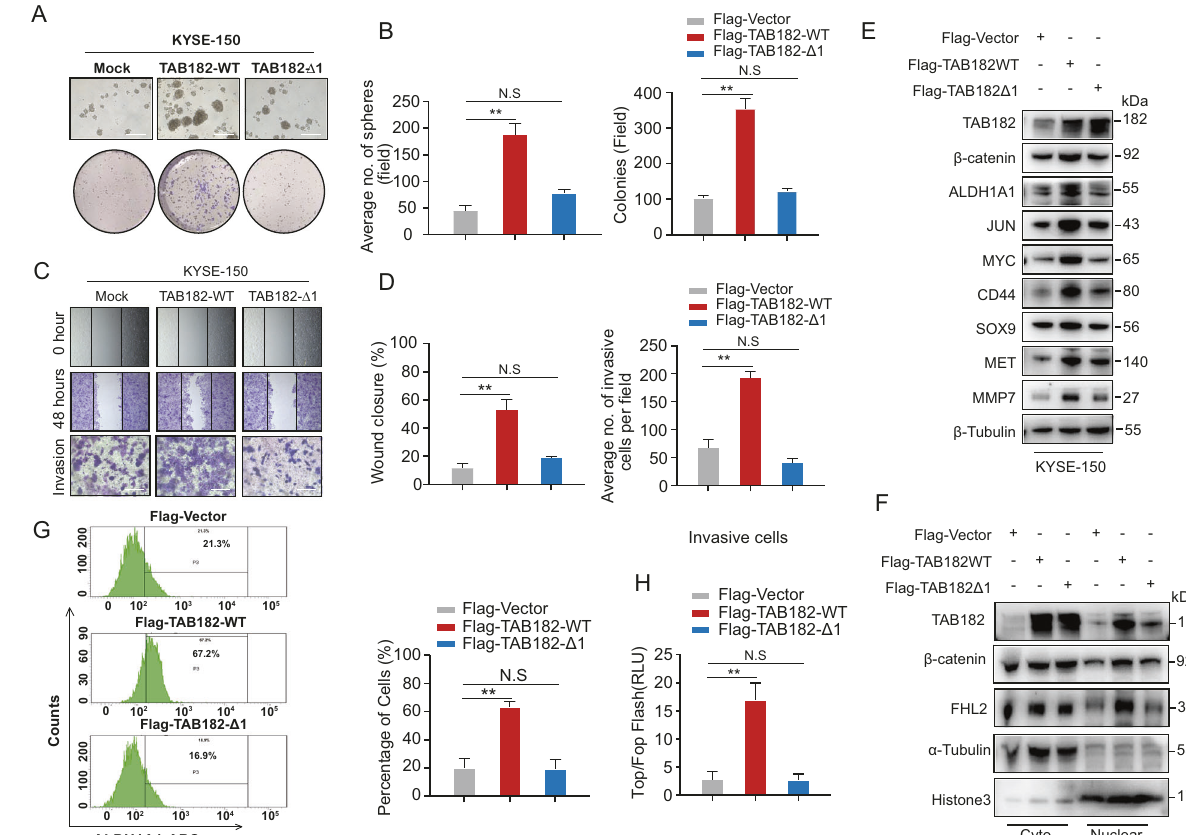
Fig. 6 TAB182 ’ s function depends on the 484-514aa domain. A , B Sphere formation and colony formation assays were conducted to evaluate the stemness and clonogenic ability of TAB182- Δ 1 and wild type-TAB182 expressed cells. C , D wound healing and transwell assays were performed to examine cell migration and invasion ability. E western blot was sued to determine β -catenin downstream target genes expression in TAB182- Δ 1 and TAB182-WT expressed cells. F distribution of TAB182, β -catenin and FHL2 protein was determined by western blot. G percentage of ALDH1A1 expressed cells was determined by FACS. H TOP/FOP luciferase assay was used to examine the β -catenin activation in the TAB182-WT and TAB182- Δ 1 expressed cells. Luciferase activity was measured 48 h after co-transduced with TOP/FOP fl ash plasmid. Three individual experiments were performed, and error bars of the data indicate mean ± S.E.M., ** P <